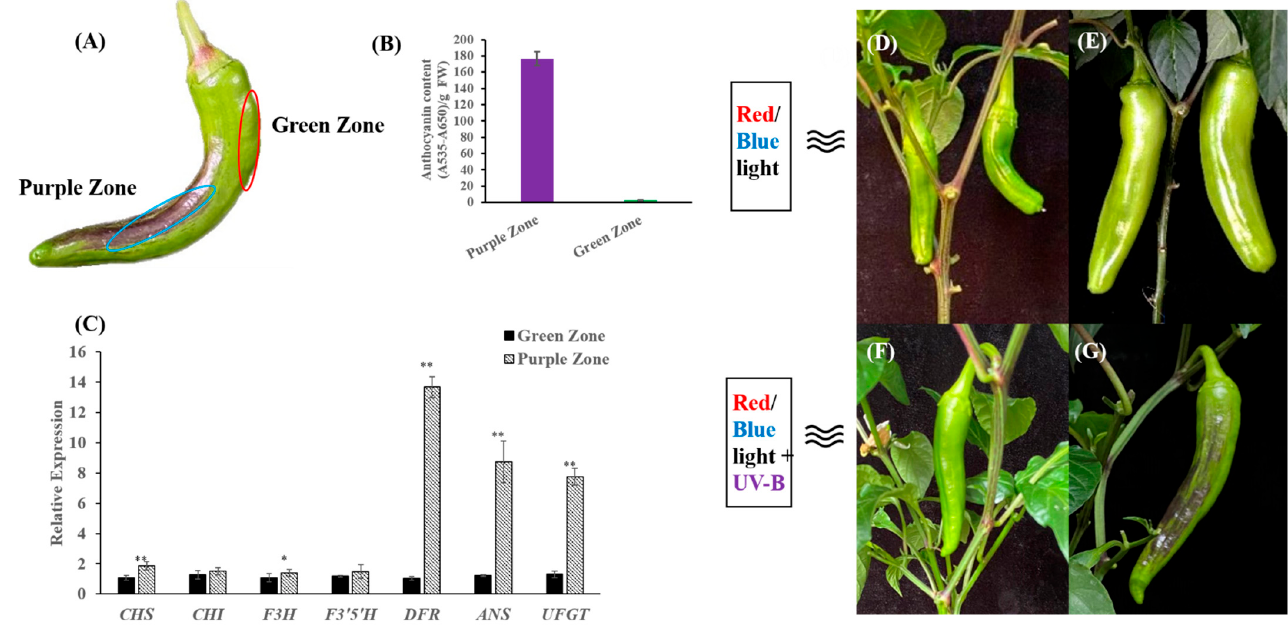
Figure 1. Analysis of anthocyanin contents, light response and expression of anthocyanin structural genes induced by UV-B in 19Q6100 pepper fruit. ( A ) Phenotype of UV-B-induced pepper fruit peels. ( B ) Anthocyanin contents in purple zone and green zone of pepper fruit peels after UV-B exposure. Numerical values are presented as means (± SE) from three independent biological replicates. ( C ) Relative expression of anthocyanin structural genes between purple zone and green zone of pepper fruit peels. Statistically significant differences between purple zone and green zone are indicated by Student’s t -test. (** p < 0.01, * p < 0.05). ( D , E ) Growth condition of pepper fruits before treatment and under red/blue light for 5 days, respectively. ( F , G ) Growth conditions of pepper fruits before treatment and under red/blue + UV-B light, respectively, for 5 days.